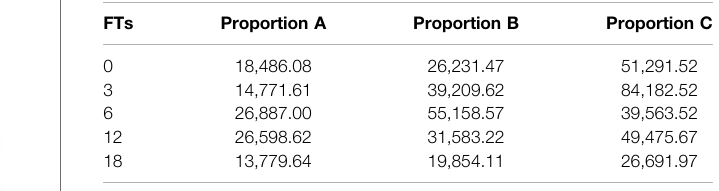
TABLE 2 | Elastic modulus of S/S sediments in FTs (kPa).